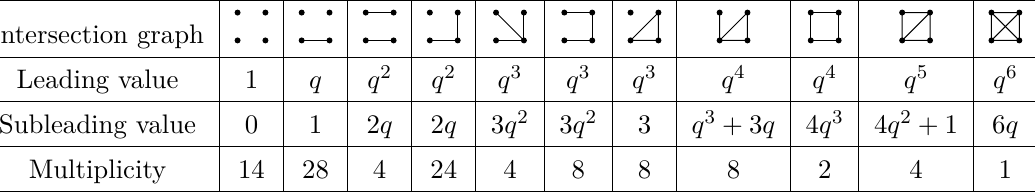
Table 3 . All the intersection graphs for the eighth